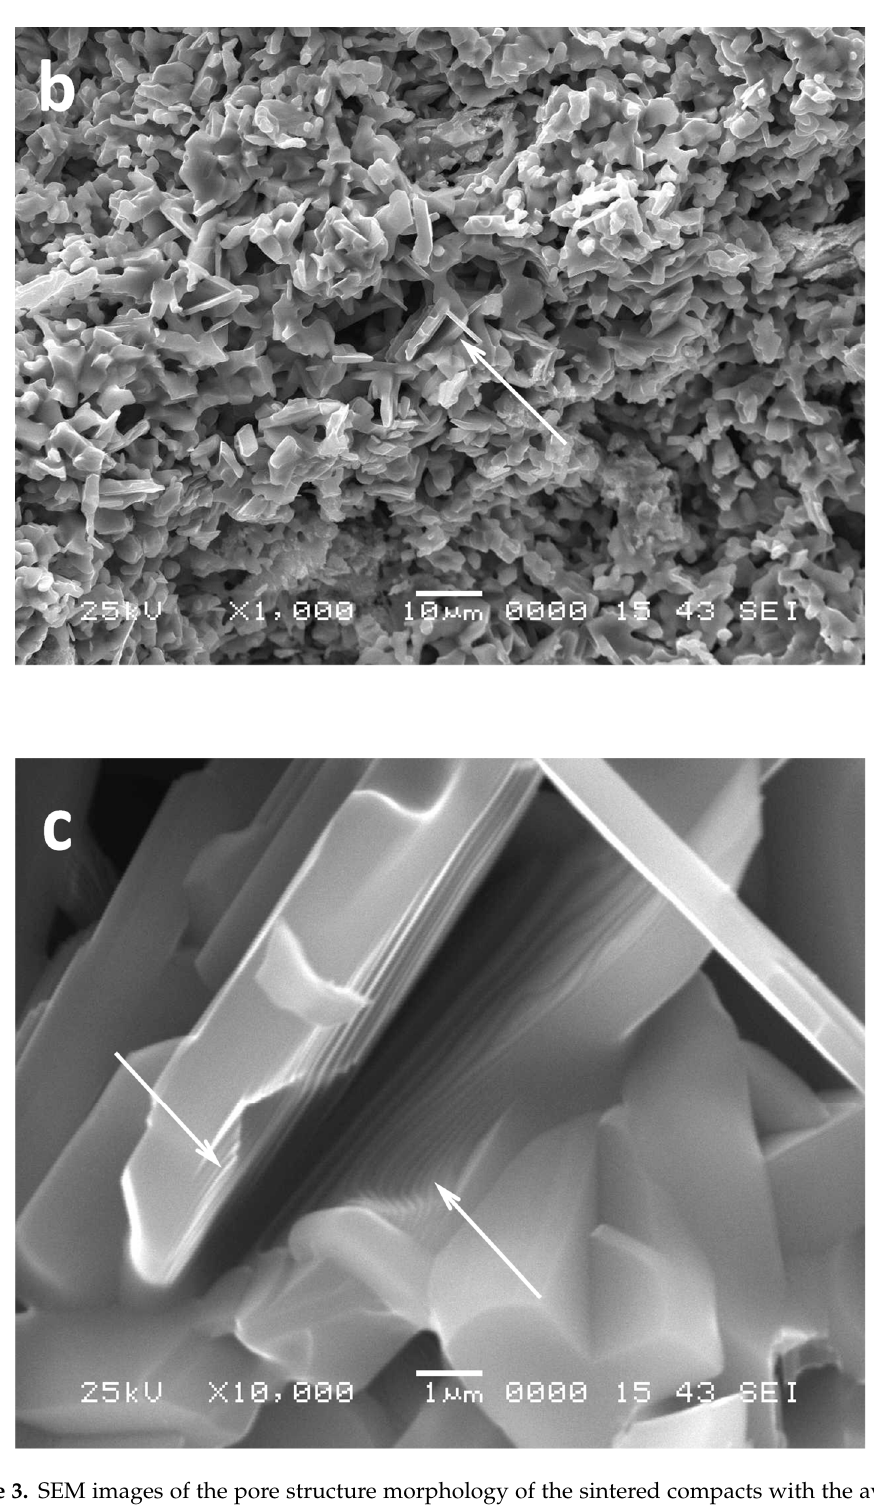
Figure 3. SEM images of the pore structure morphology of the sintered compacts with the average apertures of 6.2 μ m ( a ) and 3.0 μ m ( b ) and the lamellar microstructure of the synthesized porous Ti 3 SiC 2 ( c ).